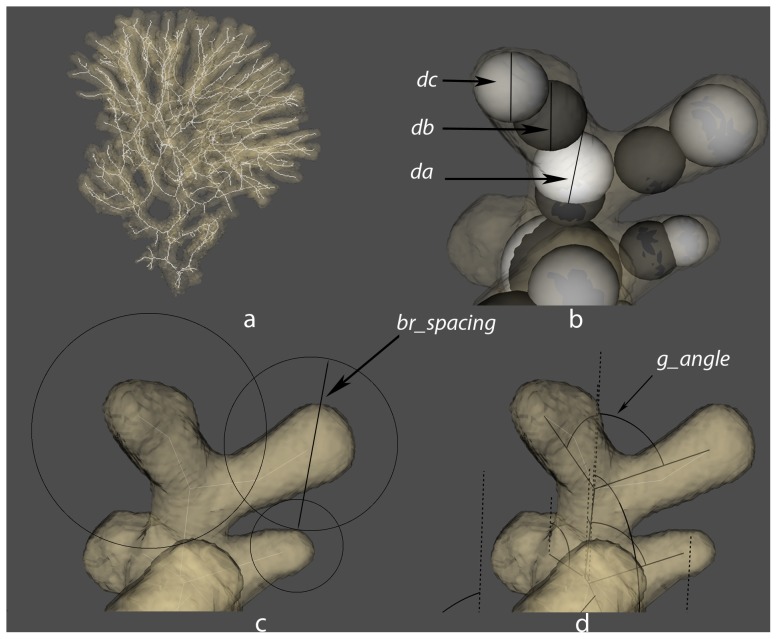
Morphometrics of branching coral colonies.a) Morphological skeleton generated from a volume of a CT scan of a Madracis colony, b) branch thickness, da – white sphere, db – black sphere, dc – gray sphere, c) branch spacing (br-spacing) and d) branching angle relative to the growth direction (g_angle).